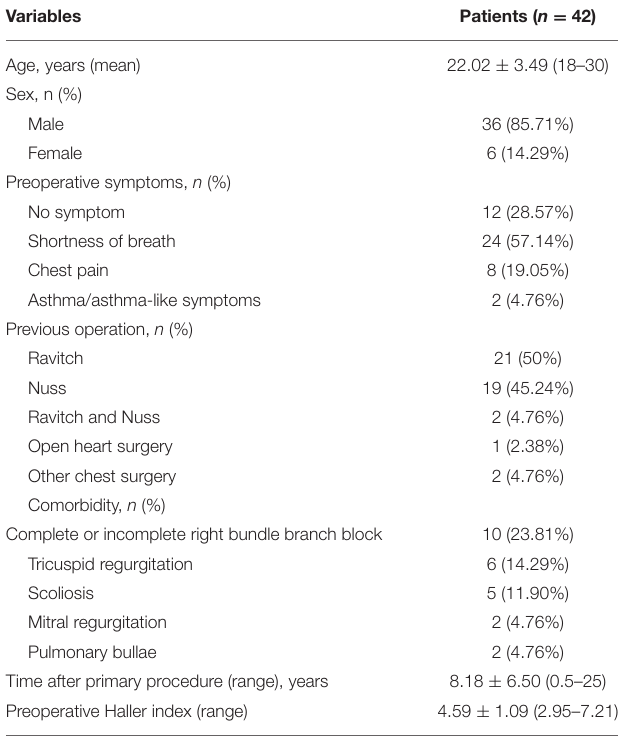
TABLE 1 | Demographic variables and preoperative characteristics of the study